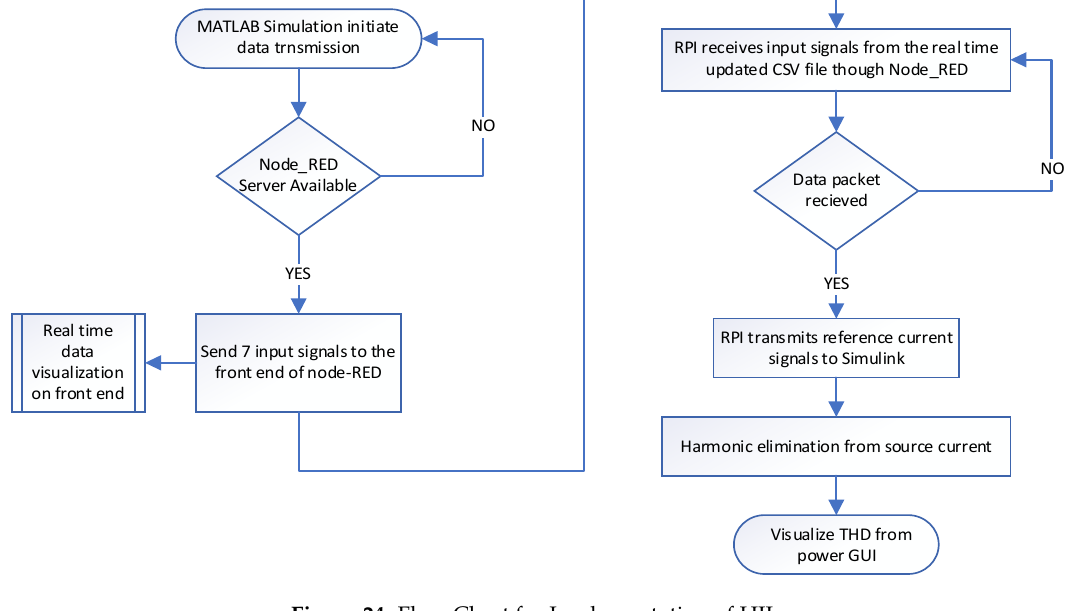
Figure 24. Flow Chart for Implementation of HIL.